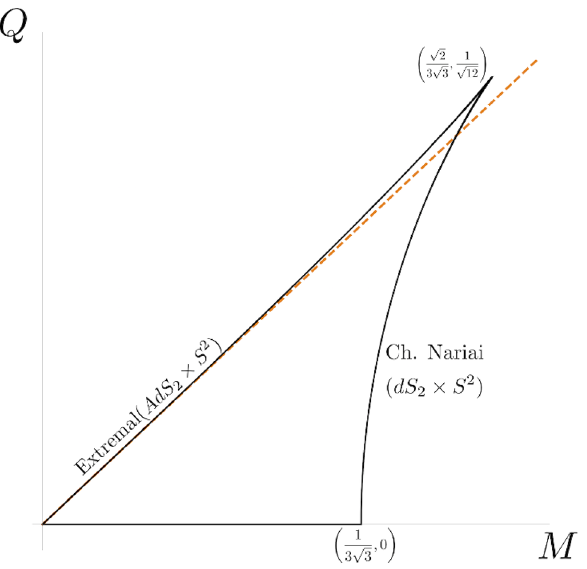
Figure 1 . Phase diagram of Reissner-Nordstrom-de Sitter black holes with the dimensionless 2 Q 2 parameters M (cid:17) GM r ; Q 2 (cid:17) Gg . Sub-extremal solutions only exist inside the shark-(cid:12)n shaped r ‘ 4 (cid:25)‘ 2 region. The boundary of this allowed region has two branches: on the top branch one has extremal RN-dS black holes, which have a AdS 2 (cid:2) S 2 horizon topology. On the lower right branch one has charged Nariai black holes, charged dS black holes in which the black hole and cosmological horizons coincide. These have a dS 2 (cid:2) S 2 near-horizon geometry. The orange dashed line is the \lukewarm line" Q = M , where the surface gravity (and hence temperature) of the two horizons are